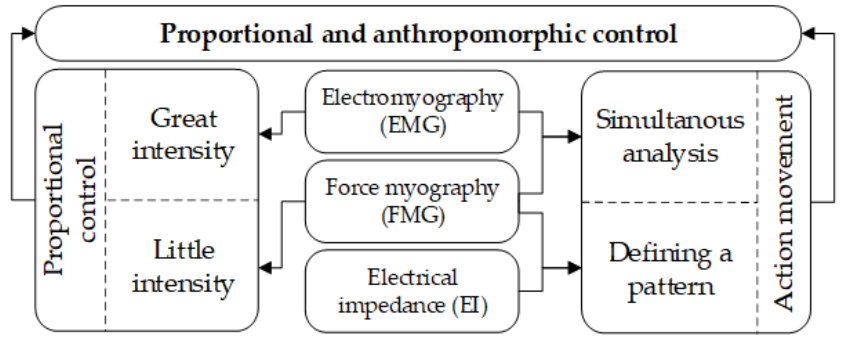
Figure 14. Scheme of simultaneous acquisition of EI, EMG, and FMG signals.